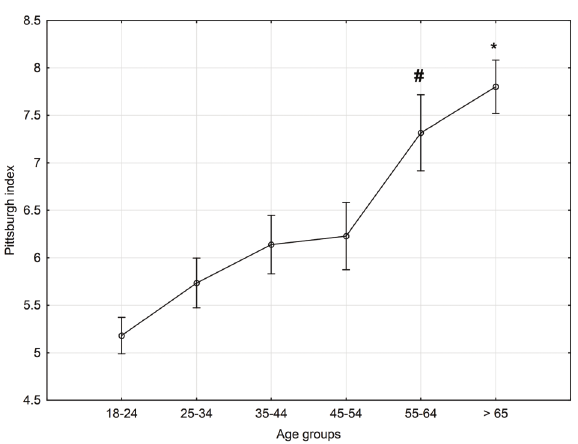
Data are reported as means ± SE.